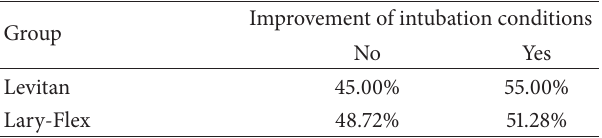
Table 5: Evaluation of participants opinion of potential improve- ment of intubation